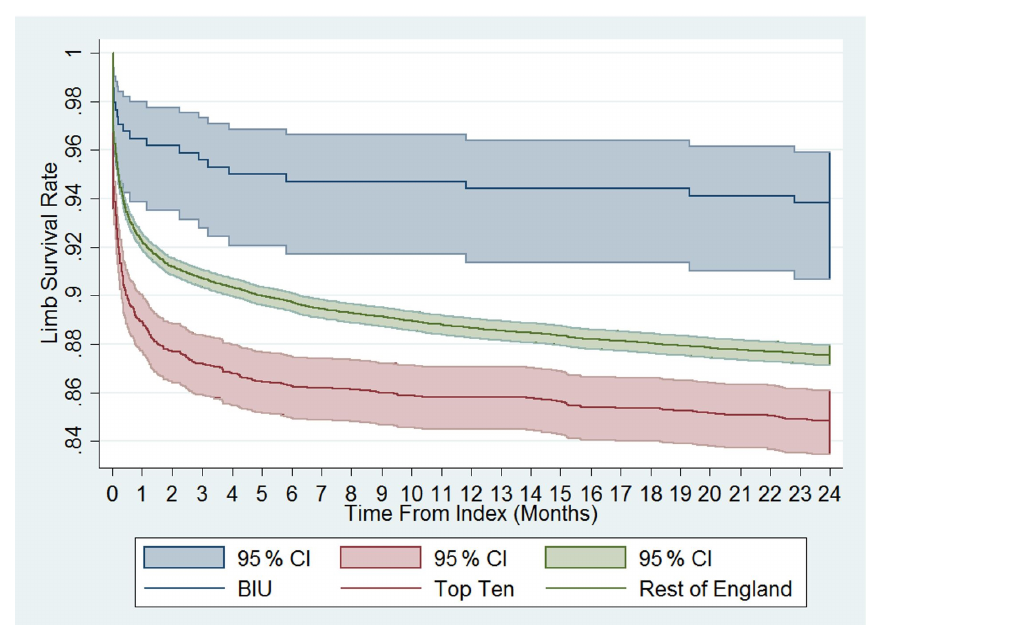
Figure 3. Cumulative limb survival rate. Time to first amputation from index procedure onwards. Comparison between the BIU, Top Ten and the rest of England.